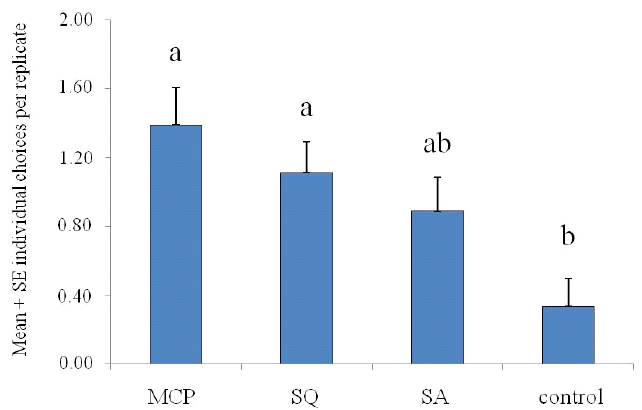
Figure 3. Four-choice olfactometer bioassays: mean ( + SE) responses of Necrobia rufipes adults to the chemicals tested; control = empty flask; MCP = methyl cyclopentenolone; SQ = squalene; SA = stearic acid. Different letters indicate statistically significant differences ( p < 0.05) among the treatments ( one-way ANOVA, followed by Tukey’s test).